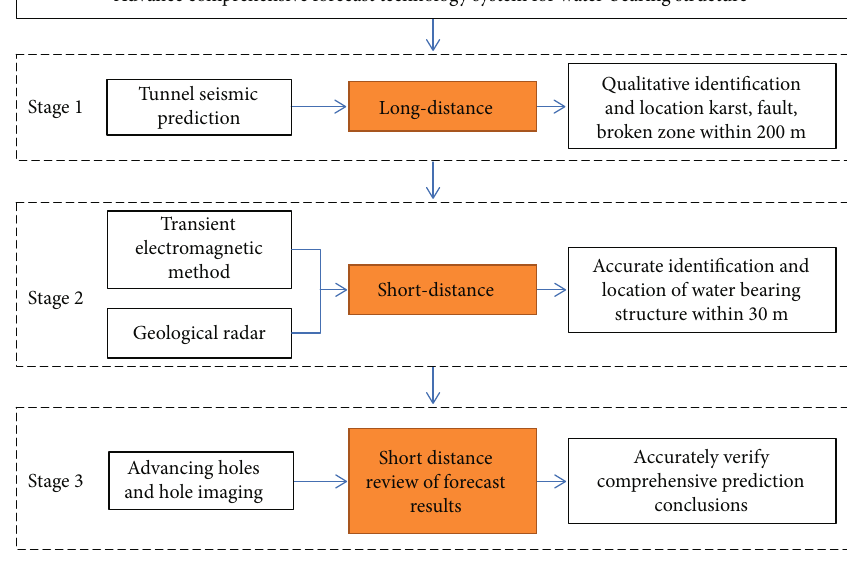
Figure 2: Integrated geological forecasting